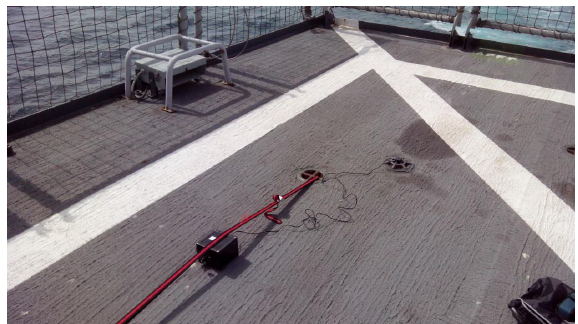
Figure 22. GPS position measurement over the helideck of the Castilla ship.